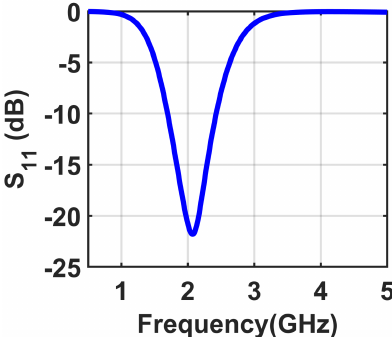
Figure 2. Numerical results of the dual polarized planar 2 × 2 supercell demonstrating the S 11